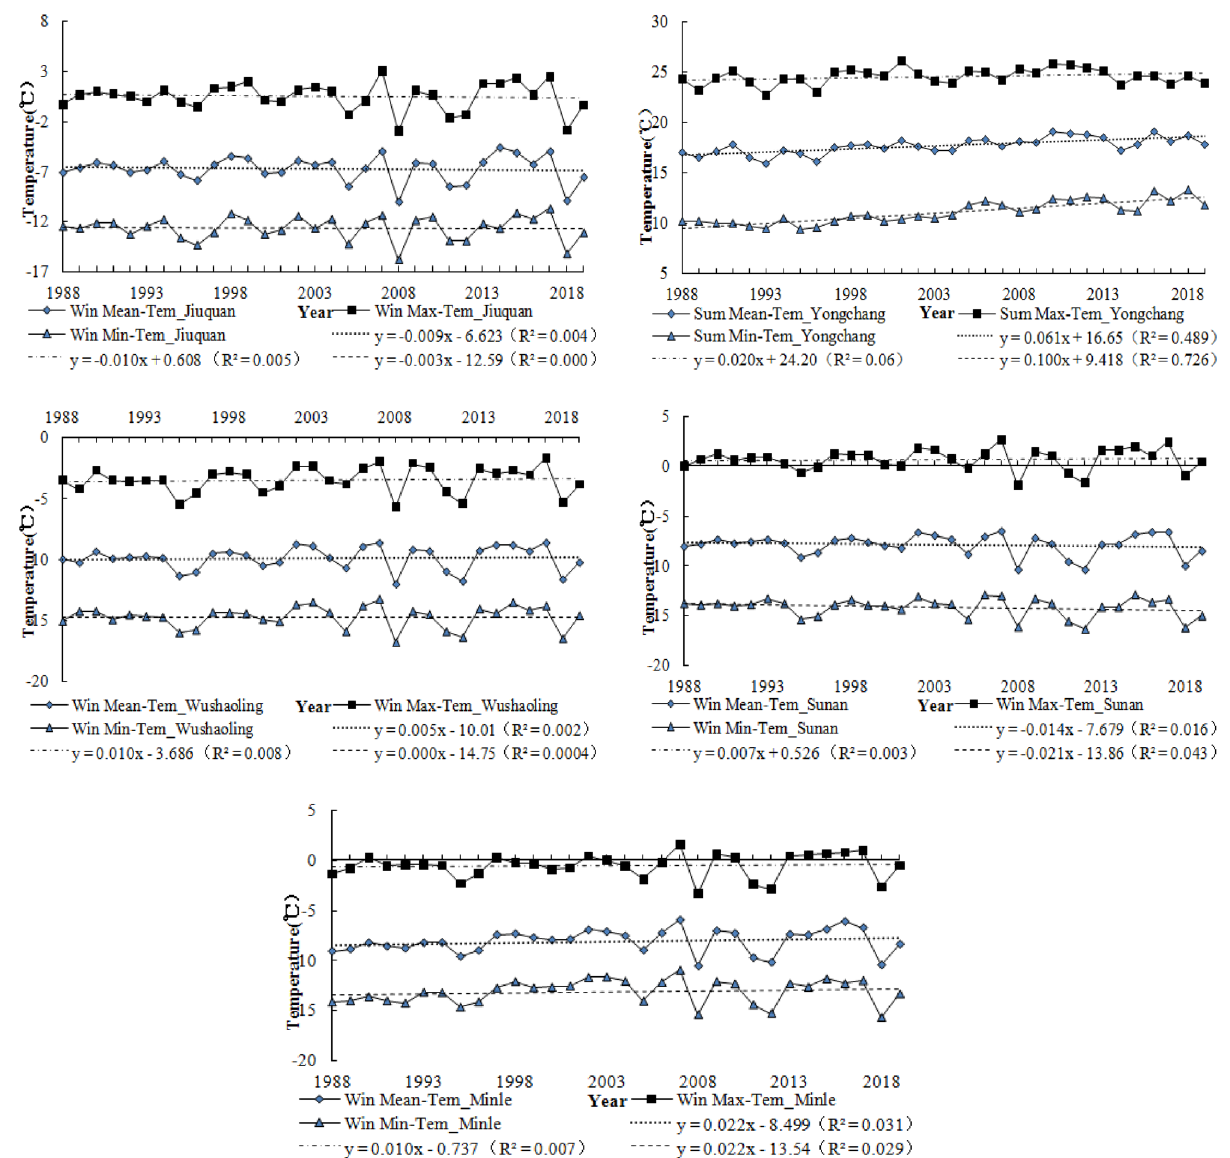
Figure 5. Trends of winter mean temperature.